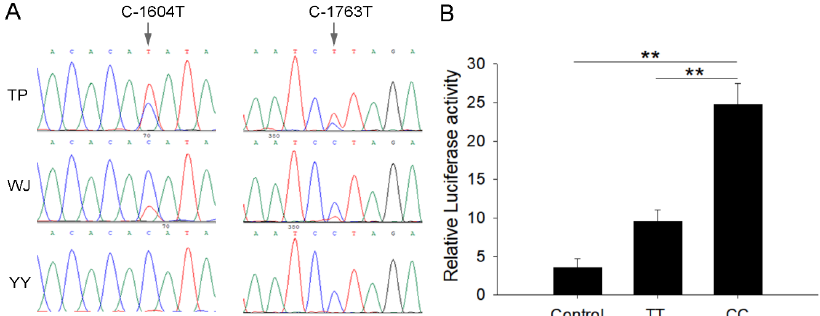
Table 1. Genotype and haplotype frequencies in the C-1763T and C-1604T in pig populations.